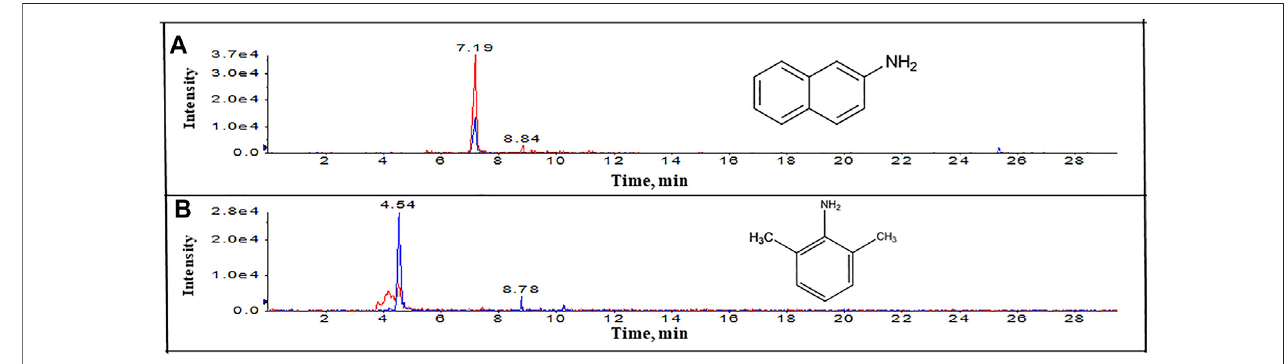
FIGURE 5 | Extracted ion chromatogram (XIC) of the two transitions to (A) 4-nitroaniline and (B) 2-naphthylamine in the collected sample 1 (untreated ef fl uent) by